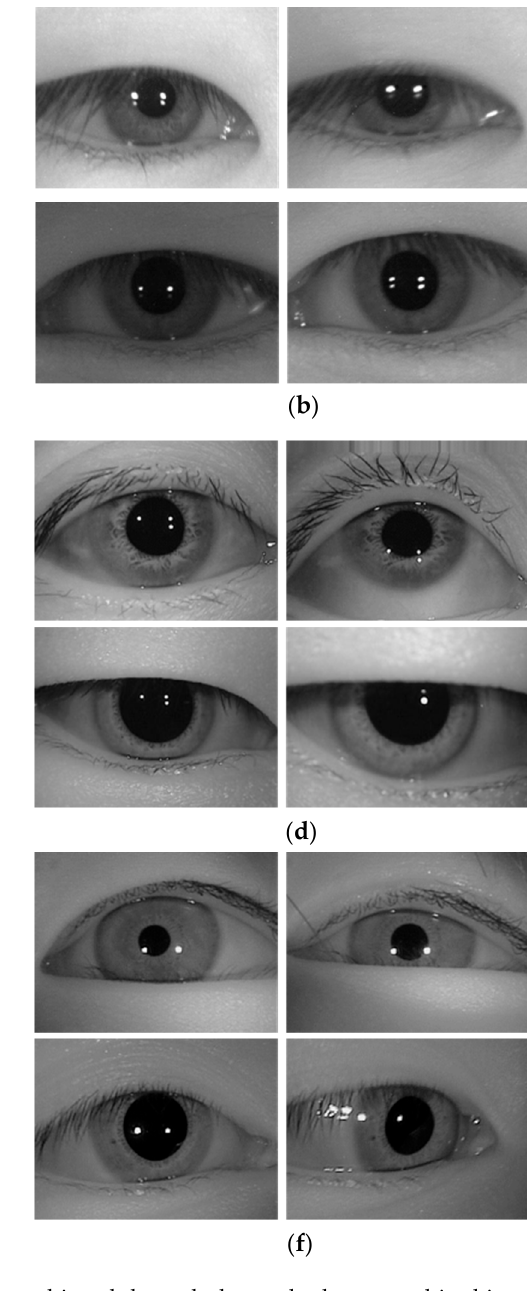
Figure 9. Examples of correction recognition cases achieved through the method proposed in this study. ( a , b ) CASIA-Iris-Distance database. ( c , d ) CASIA-Iris-Lamp database. ( e , f ) CASIA-Iris-Thousand database. In ( a – f ), the image on the left is the enrolled image, and the image on the right is the recognition attempt image.